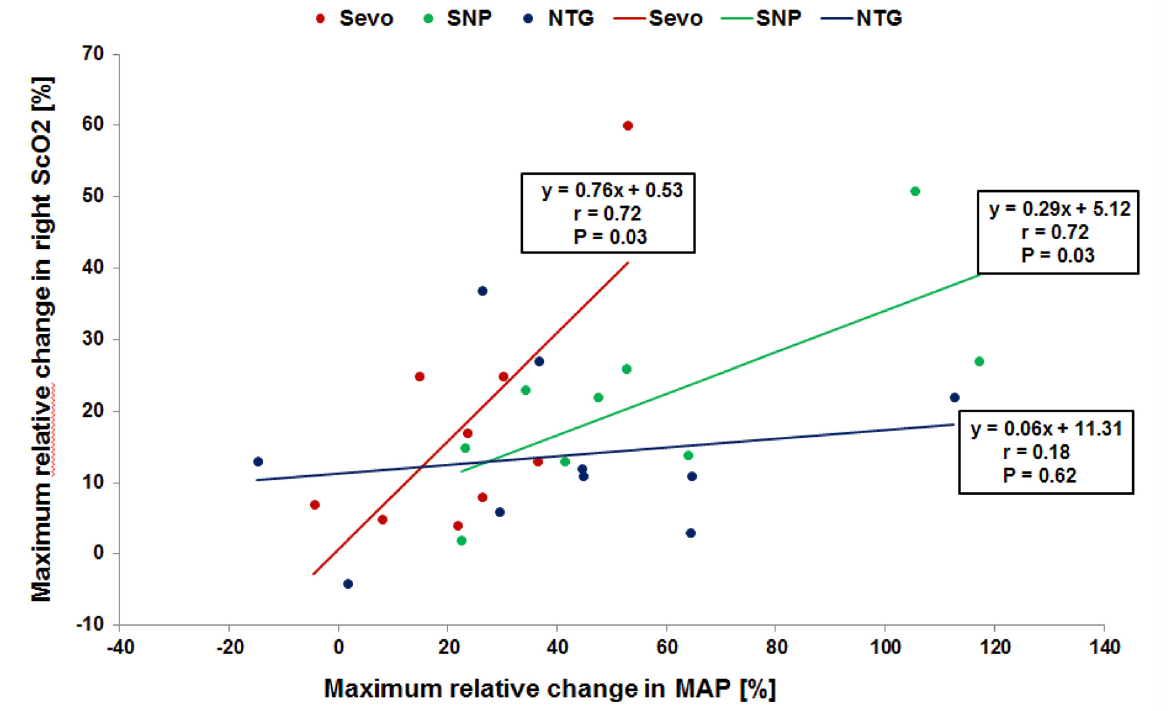
Figure 2. Correlation of changes in mean arterial pressure (MAP) with changes in cerebral oxygen saturation (S of three different vasodilating drugs. The drugs are sevoflurane (Sevo), sodium nitroprusside (SNP), and nitroglycerin (NTG). Own data, not published.